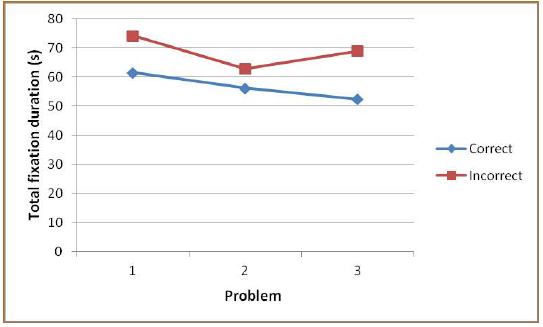
Figure 3. Average total fixation durations in each problem.